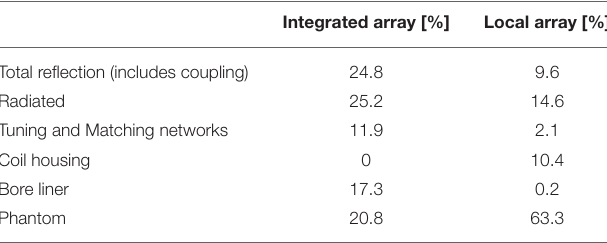
TABLE 1 | Power budget obtained by numerical simulation for the CP mode for + both arrays. Integrated array [%] Local array [%] Total reflection (includes coupling) 24.8 9.6 Radiated 25.2